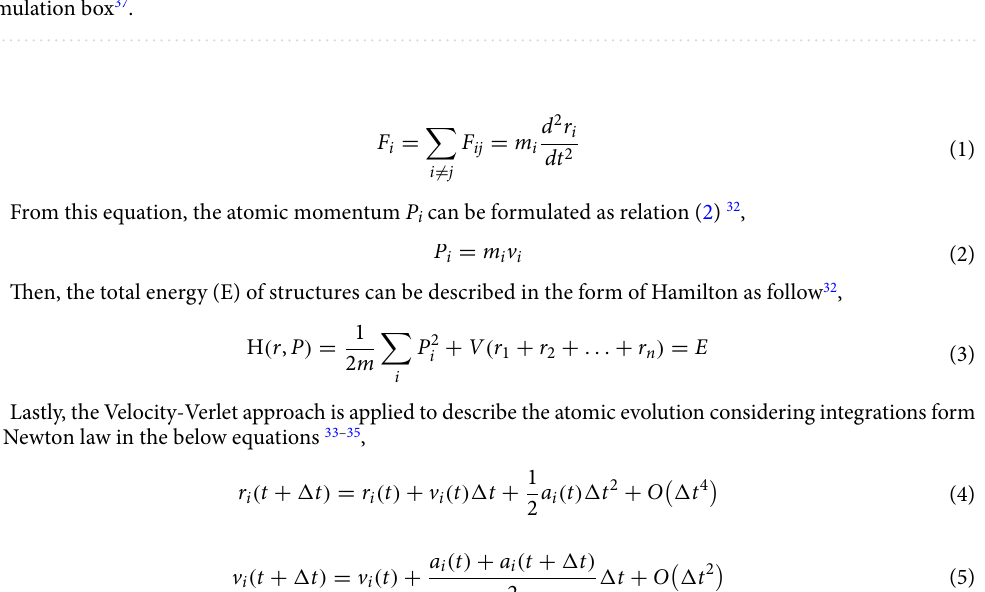
Table 1. The ε and σ constant parameters for LJ formalism and reaction of various atoms in the MD simulation box 37 .